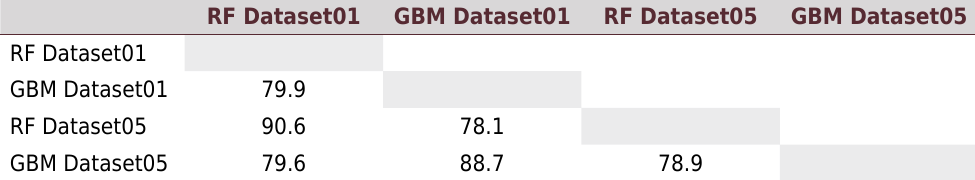
Table 4. Coincidence of majority cells prediction of soil units by RF and GBM with Dataset01 and 05 in percentage of